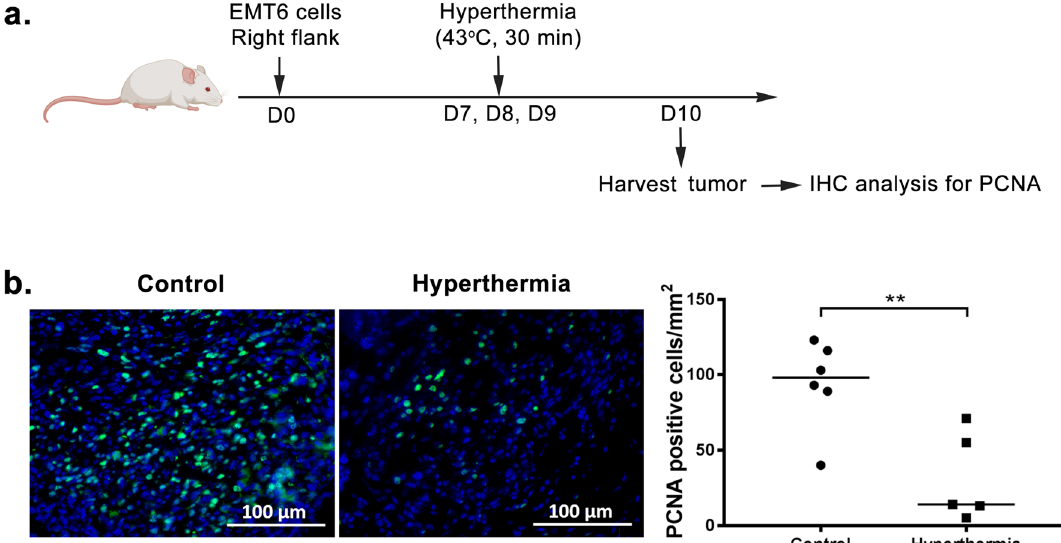
Figure 2. Local hyperthermia by NIR reduces tumor cells proliferation . Mice were sacrificed 3 days after the first treatment. ( a ) Schematic time course to examine the proliferating cells. ( b ) Fluorescence macrograph showing the expression of PCNA indicating the proliferating tumor cells and graph showing PCNA positive- stained cells per mm 2 . n = 5/6 per group. ** P < 0.005 (Student’s t